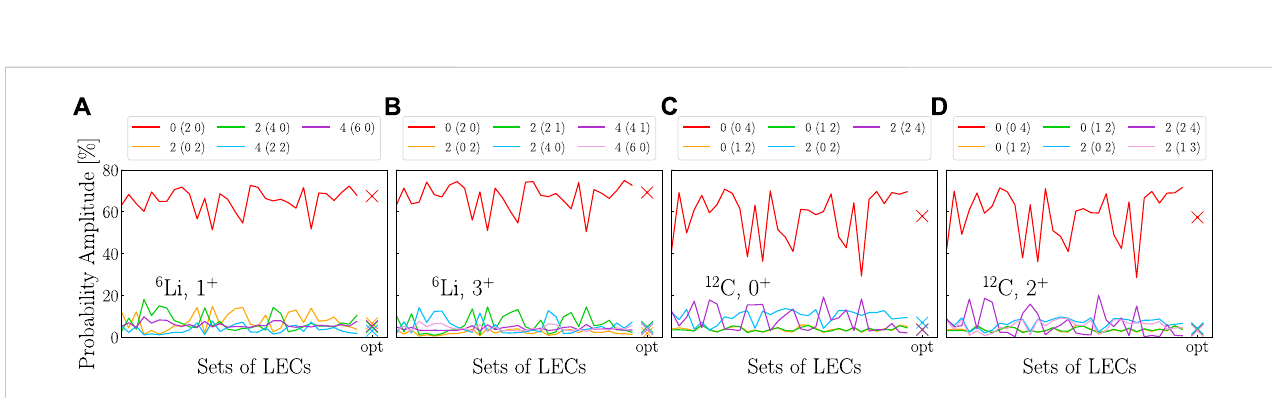
FIGURE 3 The largest SU (3) probability amplitudes (solid lines) as a function of emulator training LECs sets for (A) 6 Li 1 + ground state and (B) 6 Li 3 + 1 state in N max = 〈 2 〉 8 All 13 modelspace[allSU(3)stateshave S } = {0, 0, 0} except for 0 (1 2) with { S corresponding N max complete model space (labeled as “ opt ”